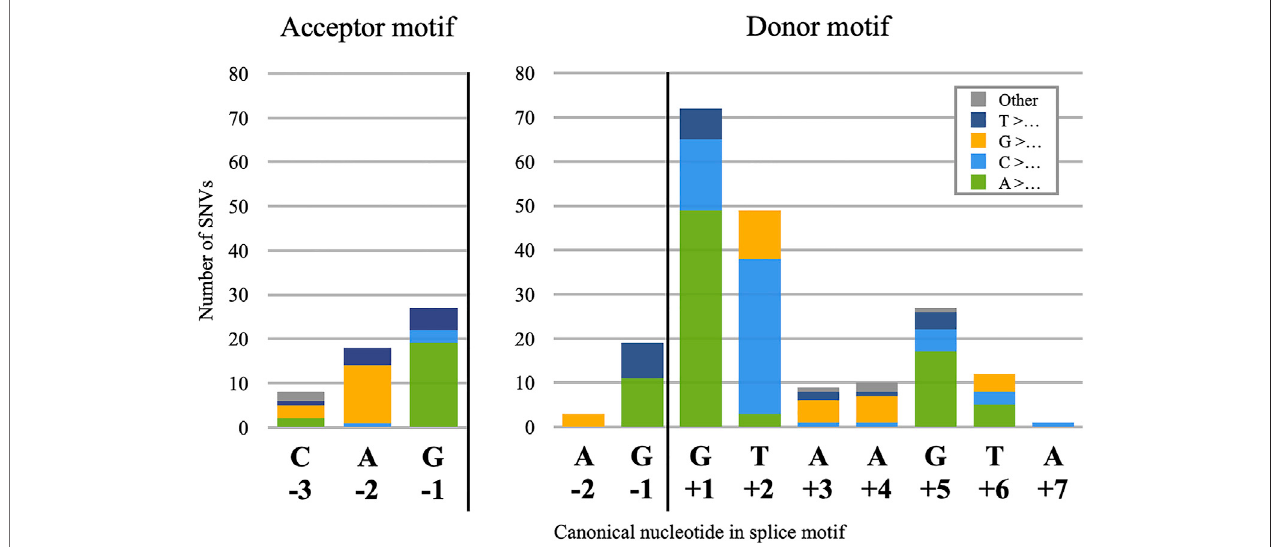
FIGURE 1 | Positional frequencies of 255 pseudoexon splice-motif SNVs. Stacked columns are categorised by the identity of the reference nucleotides, which in 249 of the 255 cases were mutated to the most frequently observed nucleotide at that position of the motifs, as shown on the X -axis. Exceptions (6) are categorised as “ Other.